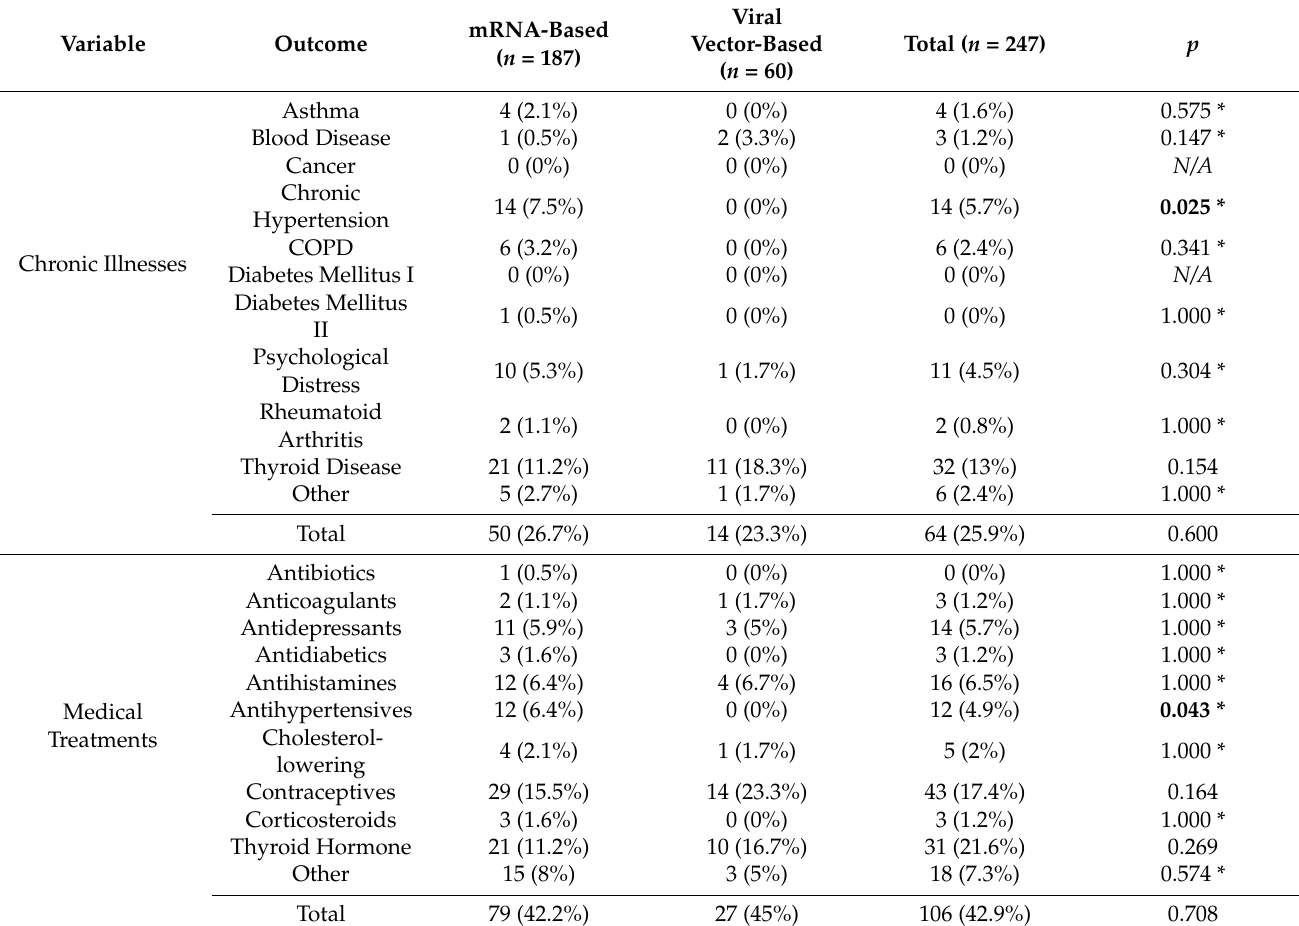
Table 2. Medical history of the surveyed Polish healthcare workers.